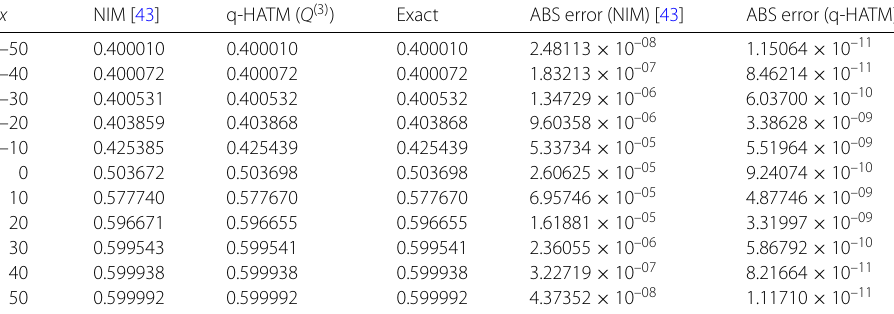
Table 9 The comparison of numerical result of Q ( x , t ) obtained by NIM [43], q-HATM, and the exact solution Equation (35), also the absolute (ABS) errors when α = 1, (cid:2) = –1, k = r = λ = 0.1, and n = 1 for Example 4.2